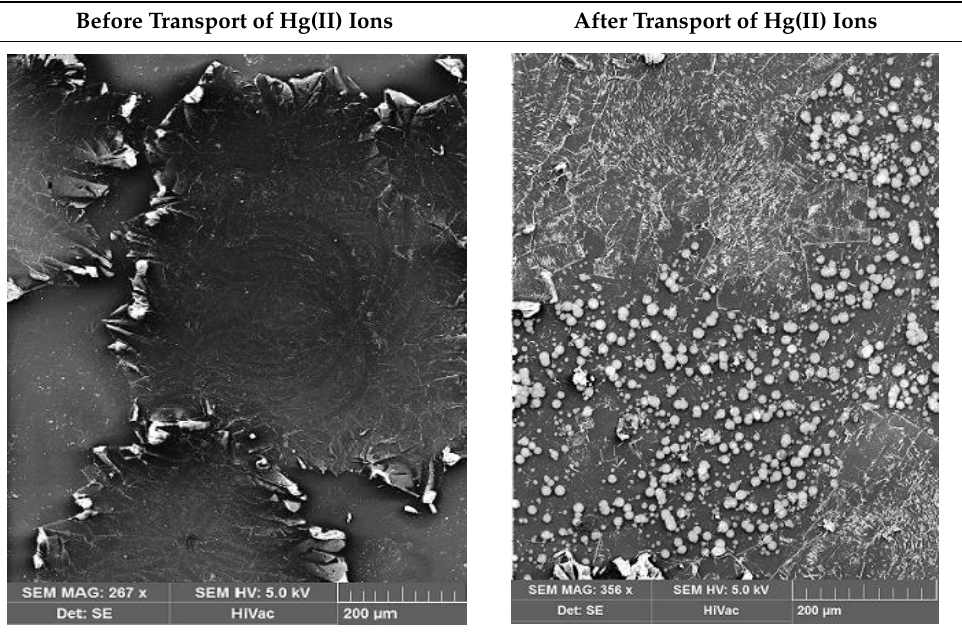
Table 1. SEM images before and after the transport of Hg(II) ions across PIM containing KP. Source phase: 1.0 × 10 −6 M Hg(II); membrane: 19 wt.% of CTA, 4 wt.% of KP, 77 wt.% of o -NPOE; receiving phase: 0.1 M NaCl.